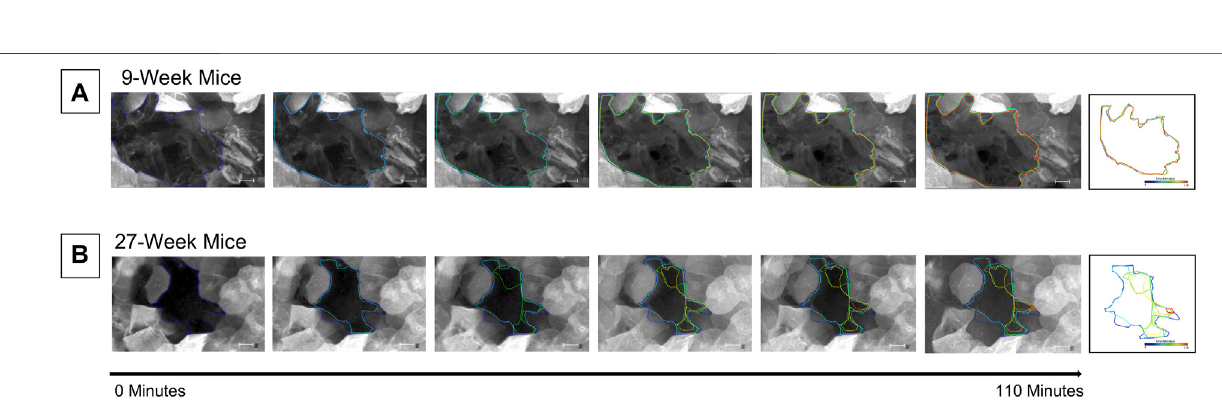
FIGURE3| Cellsenterthewoundbedwithin2 hofinjuryin27-weekbut not9-weekoldmousecorneas. Enucleated globeswerestainedwithCellMask DeepRed (greyscale) and imaged on the ZeissLSM 880 confocal microscope toobservewound healing progress for 1 hour and 45 min. T = 0 is15 min after injury. There is a15- min interval between each image. The border ofthe wound wastracedat each time point using ImageJ and superimposed on the image. Previous wound borders were also superimposed totrack changes inthe wound border over time. The right-most image depicts the superimposed changesin the wound edgetrackedthrough time. The wound border in the cornea from 9-week mice (A) remained approximately the same throughout the duration of the experiment. In the corneas from 27-week mice (B) the perimeter of the wound became smaller due to an in fl ux of cells into the wound bed. The data represent three eyes per condition, with each eye from one mouse. Scale bar represents 50